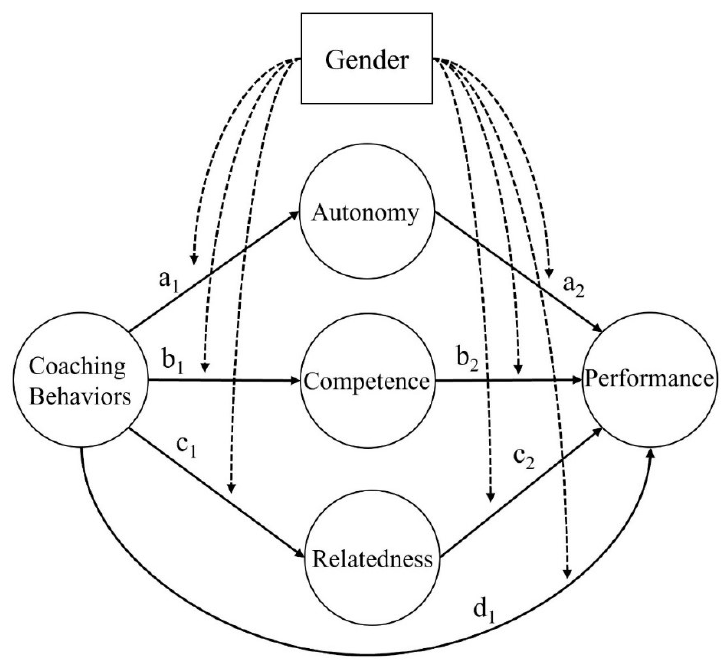
Figure 1. The proposed model in this study.